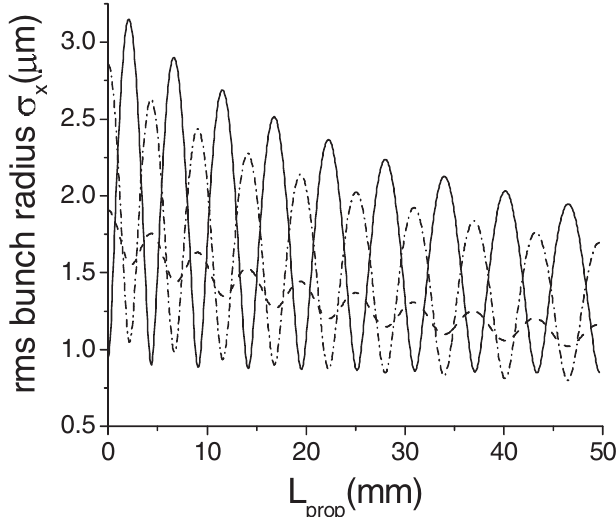
FIG. 4. The rms radius of an electron bunch as a function of propagation distance in the laser wakefield presented in Fig. 1. (cid:1) 400 ), the normalized The injection energy is 204.4 MeV ( h (cid:4) i 0 and " are 0 : 95 (cid:1) m , the rms relative transverse emittances " nx ny energy spread is 2%, and the FWHM bunch duration is 0.75 fs. The initial rms bunch radii are 0 : 96 (cid:1) m (solid curve), 1 : 91 (cid:1) m (dashed curve), and 2 : 87 (cid:1) m (dash-dotted curve). The bunches are injected on-axis into the accelerating region, at (cid:6) (cid:1) (cid:2) 9 : 5 (see Figs. 1 and